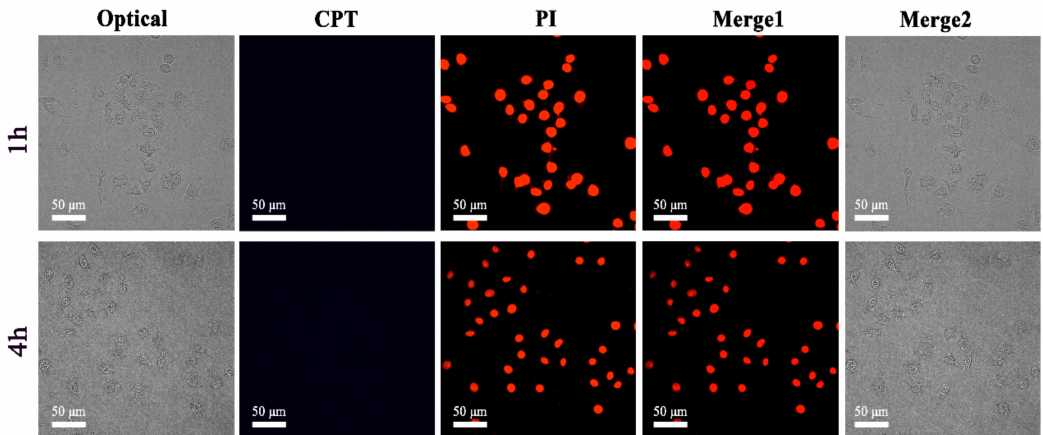
Figure 3. Cellular uptake of CPT-HT-J-ZL 12 in HepG2 (no expression of PSMA) cells. CLSM images of HepG2 cells incubated with CPT-HT-J-ZL 12 (10 µ M) for 1 and 4 h. Nuclei were stained by PI (red), the blue color was indicative of CPT . CPT : false-color green. For CPT : λ ex = 405 nm, band-pass filter λ = 500–550 nm. For PI: λ ex = 561 nm, band-pass filter λ = 575–625